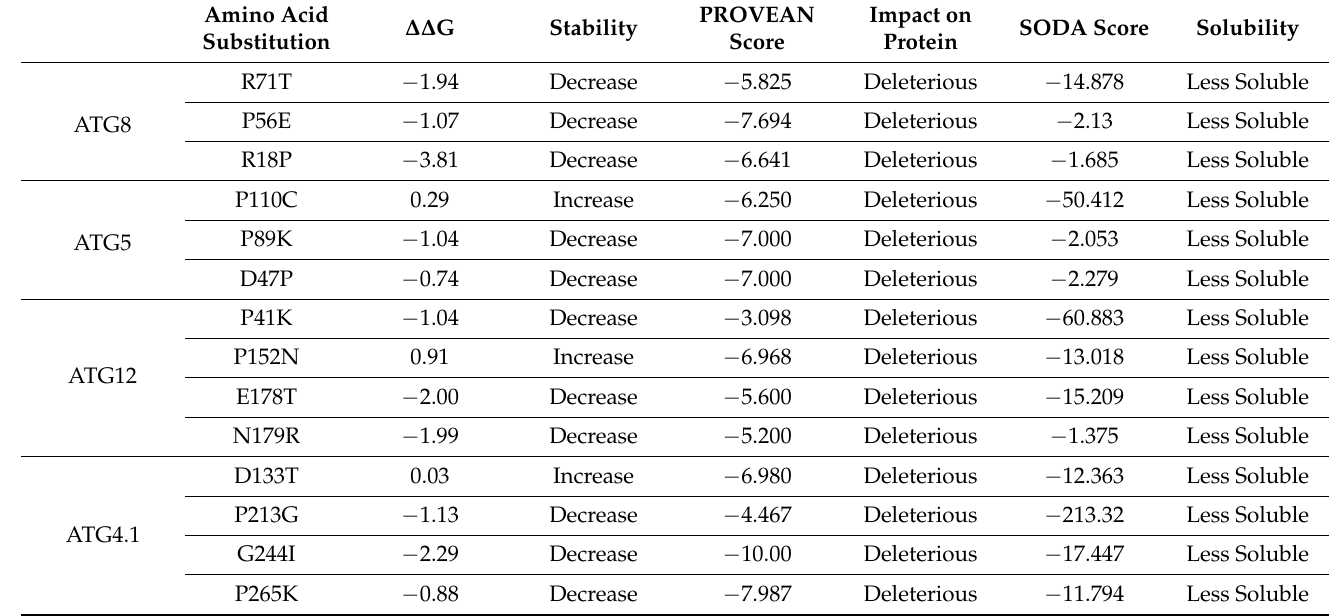
Table 1. Amino acid substitution due to a specific mutation and its impact on Gibbs free energy ( ∆∆ G) and ultimately on protein stability, Protein Variation Effect Analyzer (PROVEAN) score reflects the functional effect of amino acid changes and their impact on protein functionality, SODA predicts the impacts of sequence variations on protein